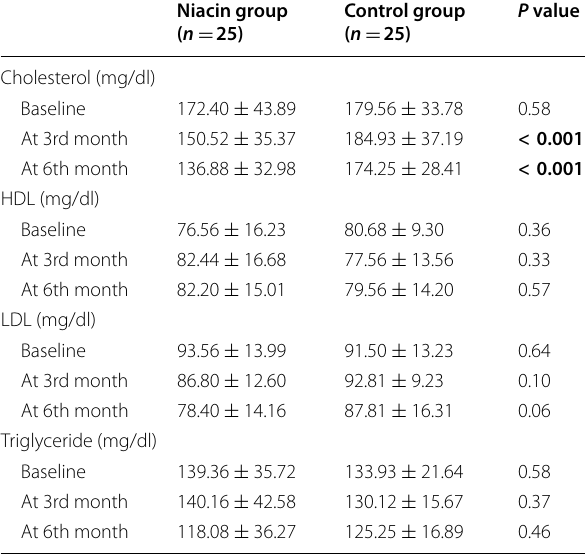
Table 4 Changes in lipid profile among studied groups